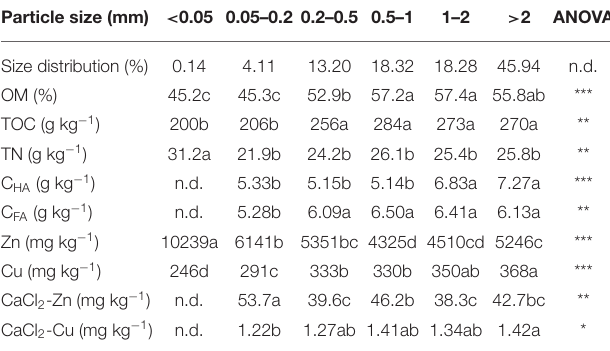
TABLE 3 | Characteristics of the different particle size fractions in Compost 1.